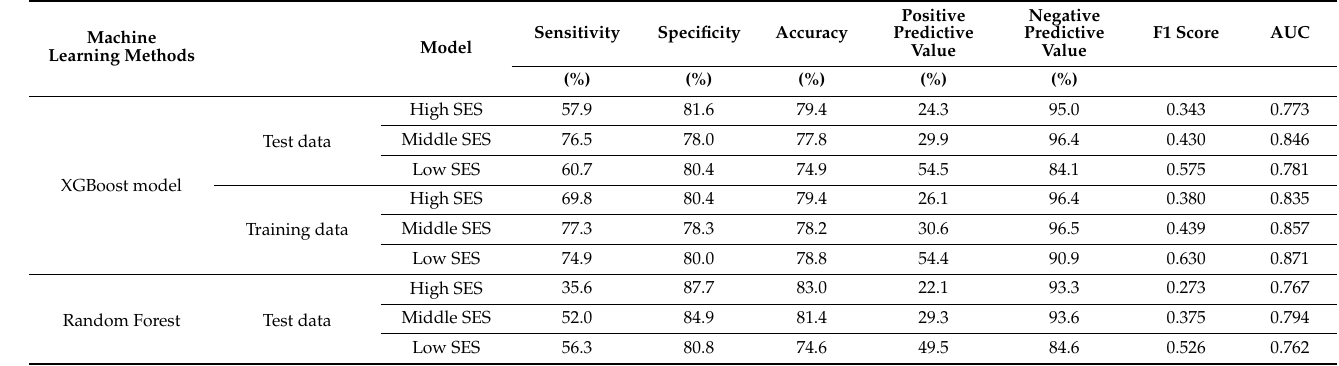
Table 2. Confusion matrix and prediction scores of XGBoost models by socioeconomic status.